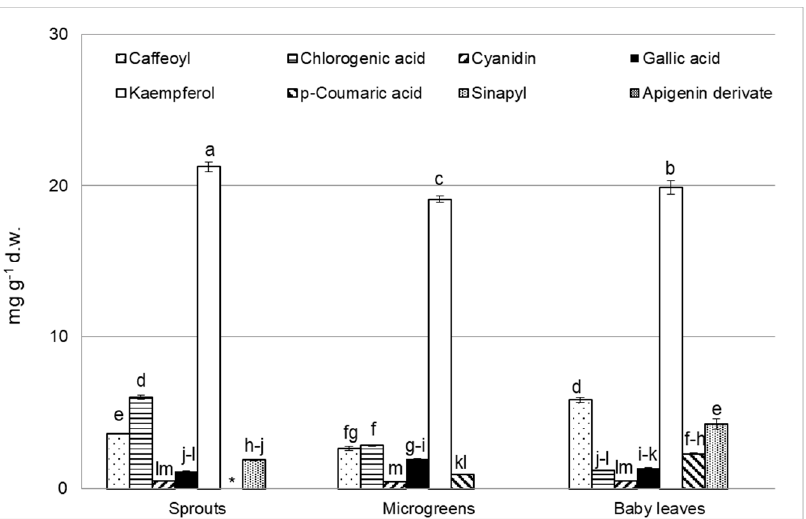
Figure 4. Polyphenol compounds for CL at different growth stages. Data are reported as mean ± S.E. Bars with the same letters are not significantly different, as determined by Tukey’s test (p < 0.05). Symbol * = not detected compound.